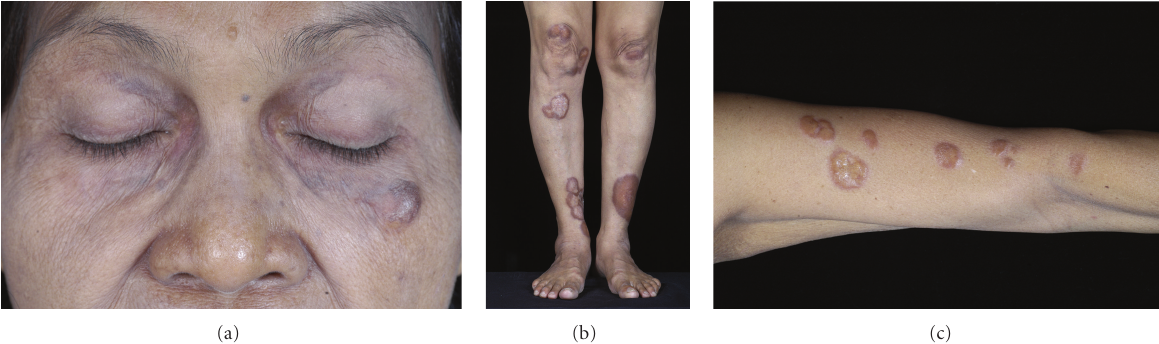
Figure 1: Physical examination demonstrated multiple yellowish to reddish-brown nodules and plaques on face (a) and extremities (b). Some lesions were observed to have central ulceration and atrophy (c).